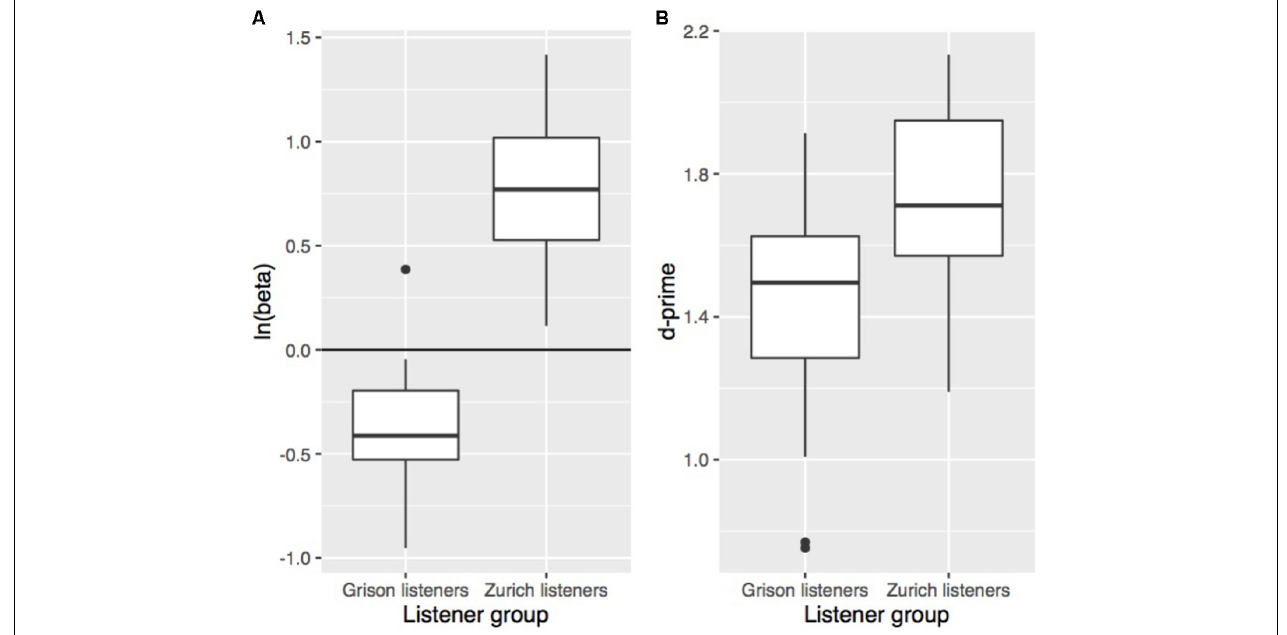
FIGURE 2 | Response bias (A) and sensitivity (B) according to a listener’s origin (left: Grison listeners; right: Zurich listeners). The measures were calculated across conditions including all 48 words. Each boxplot contains one value per subject of the respective